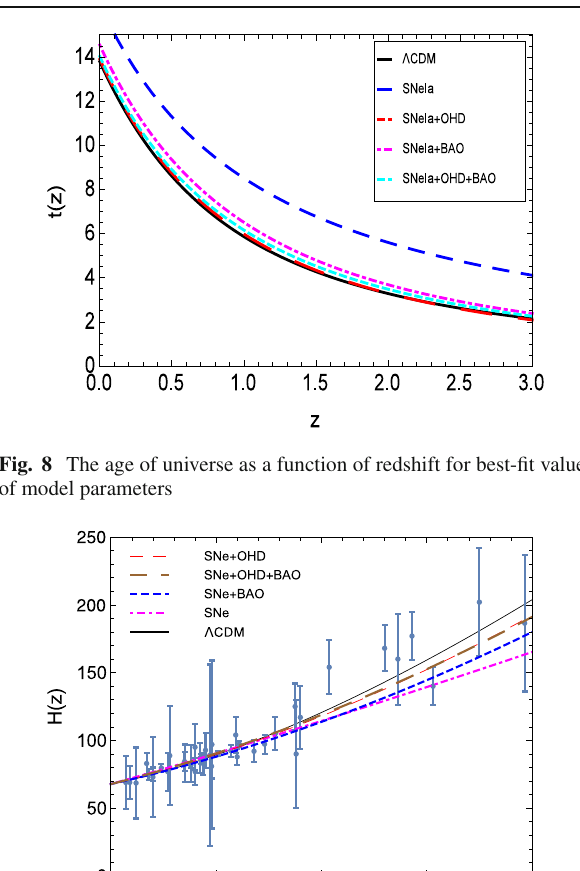
z Fig. 12 The trajectory of Om(z) for the best fitted